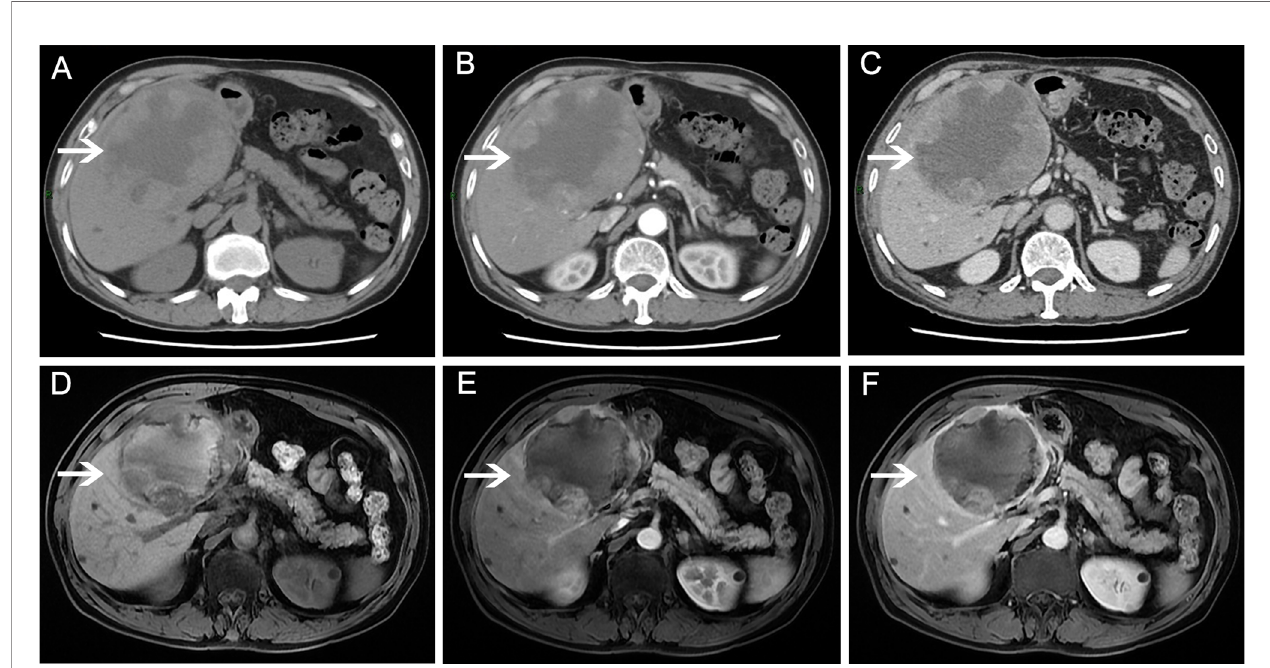
FIGURE 2 | Abdominal magnetic resonance imaging (MRI)/computed tomography (CT) scans before and after apatinib therapy. Before apatinib treatment, a CT scan showed a mass with cystic and solid masses. (A) plain scan; (B) arterial phase; (C) venous phase. After 3 months of apatinib treatment, MRI revealed that the tumor mass decreased signi fi cantly. (D) T1-weighted image; (E) arterial phase; (F) venous